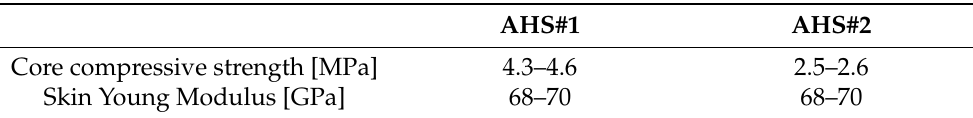
Table 2. Mechanical properties of aluminium honeycomb sandwich panels.